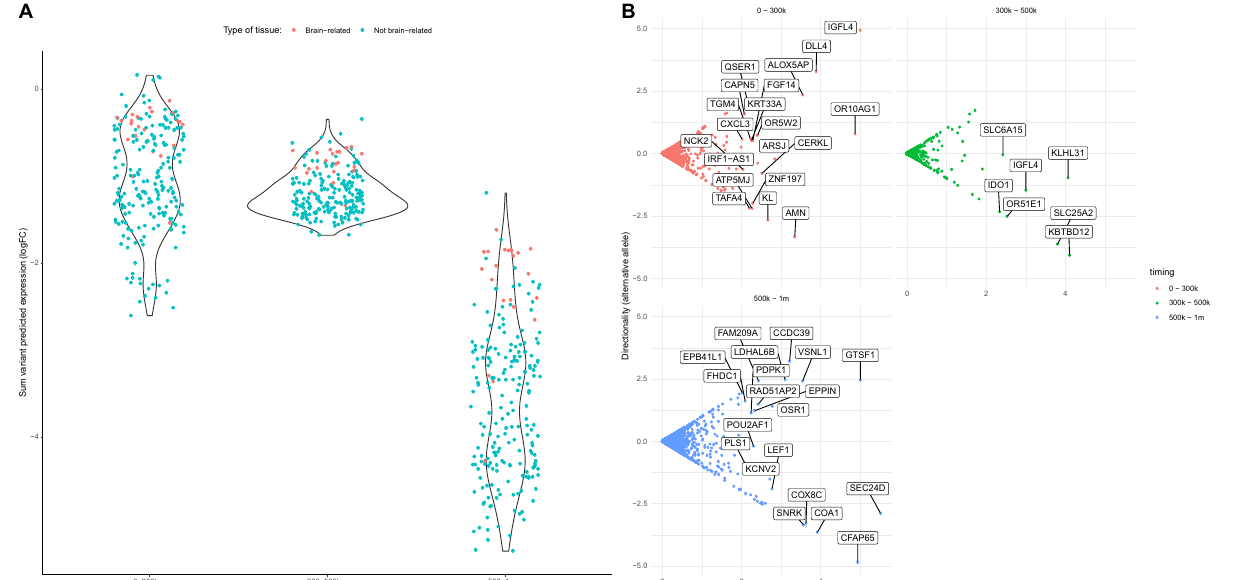
Figure 4. ( A ) Sum of all directional mutation effects within 1 kb to the TSS per time window in 22 brain and brain-related tisues (red) and the the rest of tissues included by the ExPecto trained model as a control group (blue). Significant differences exist across time periods when non-brain and brain-related tissues are compared (Kruskal–Wallis test; p = 2.2 e − 16 ). ( B ) Genes with a high sum of all directional mutation effects, and cumulative directionality of expression values in brain tissues per time